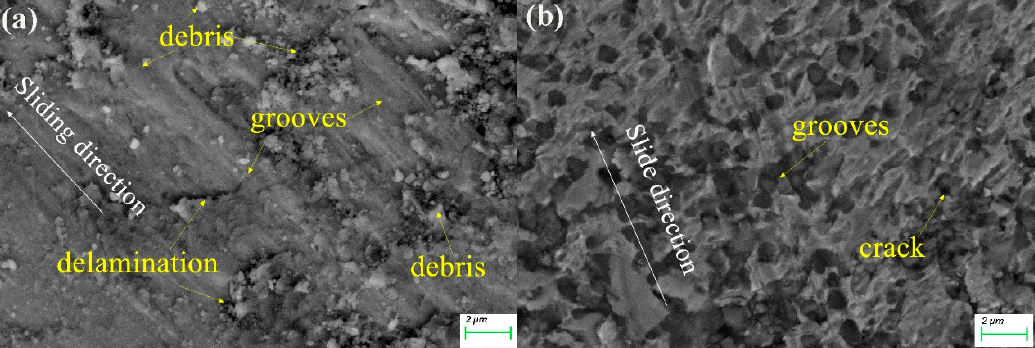
Figure 7. The worn surface SEM image of ( a ) the HEA dry wear and ( b ) HEA with lubrication.